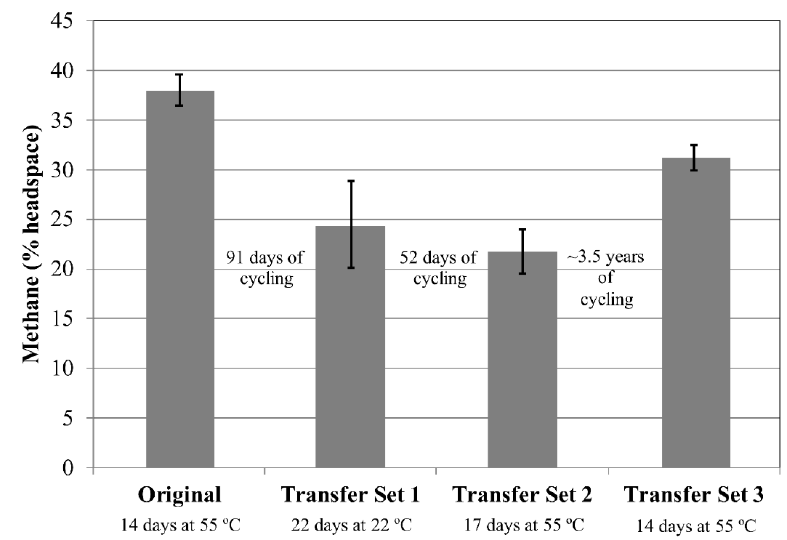
Figure 3. Methane production by Methanothermobacter wolfeii following an initial incubation period for each of three sets. Test tubes for the Original Set and for Transfer Sets 1 and 2 contain 5 g sand and 10 mL MM medium. Transfer Set 3 tubes contain 10 mL MM medium only. Transfer Set 1 tubes ( n = 5) were inoculated from one tube in the Original Set ( n = 4) following 105 days of freeze/thaw cycles. Transfer Set 2 tubes ( n = 5) were inoculated from the corresponding tube within Transfer Set 1 following 74 days of freeze/thaw cycles. Transfer Set 3 tubes ( n = 5 *) were inoculated from the corresponding tube within Transfer Set 2 on Day 1494. Specific freeze/thaw cycles (time, temperature) are given in Table 2. Specific inoculation schemes between sets are given in the supplementary material. Error bars indicate ± one standard deviation. * One replicate did not produce any methane and is not included in the data shown